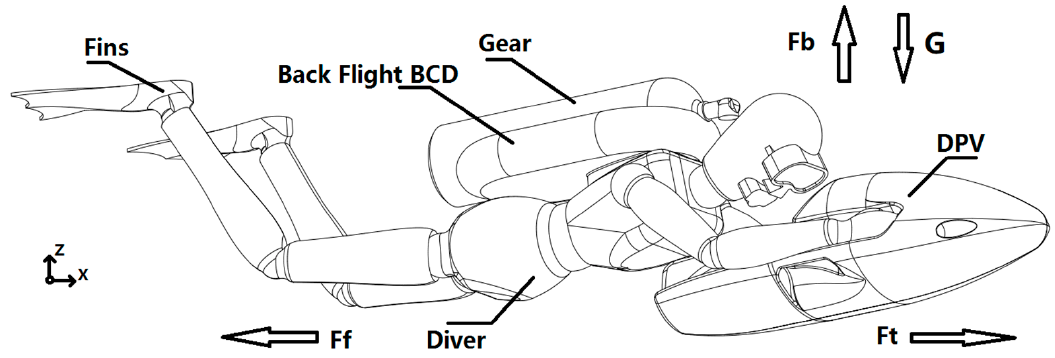
Figure 5. Forces on diver–DPV coupled model.